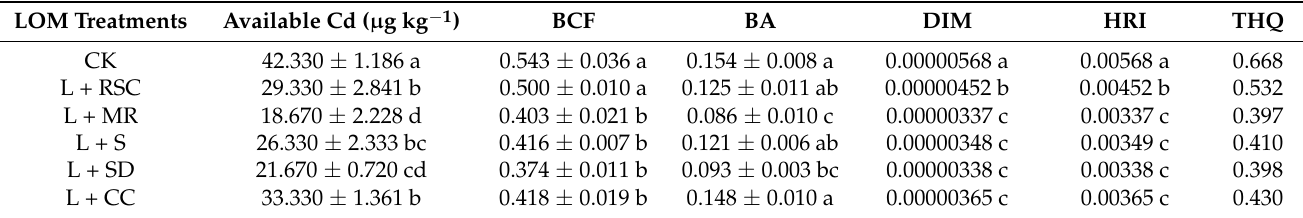
Table 4. Effect of LOM on soil available Cd concentration, Cd bioconcentration factor (BCF), and Cd bioavailability (BA) of A. selengensis , daily intake of Cd (DIM), Cd-associated health risk index (HRI), and the target hazard quotient (THQ) related to A. selengensis cultivated on Cd-contaminated soil. All values are means of three replicates ± standard errors. Different lowercase letters indicate significant variability among treatments ( p <